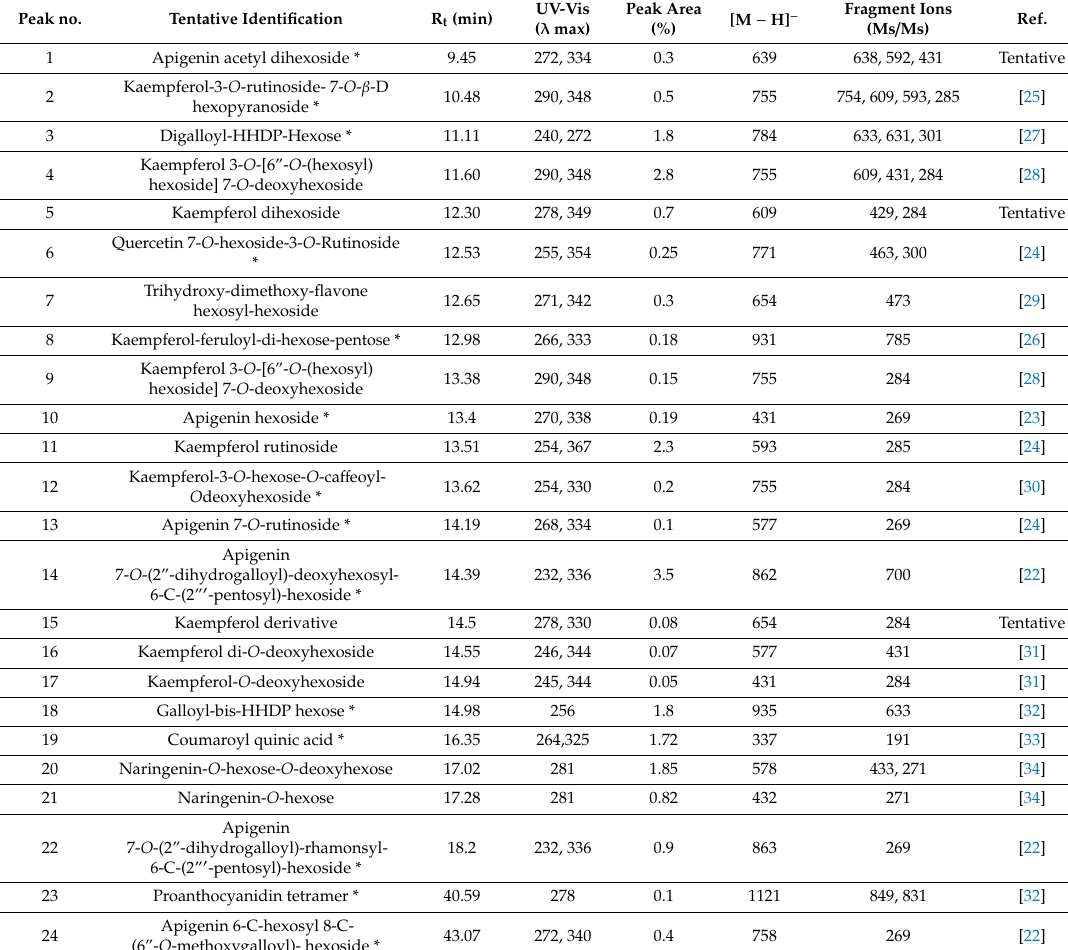
Table 1. Characterization of secondary metabolites in the hydroalcoholic extract of SJ fruits by HPLC-PDA-ESI-MS / MS. Peak